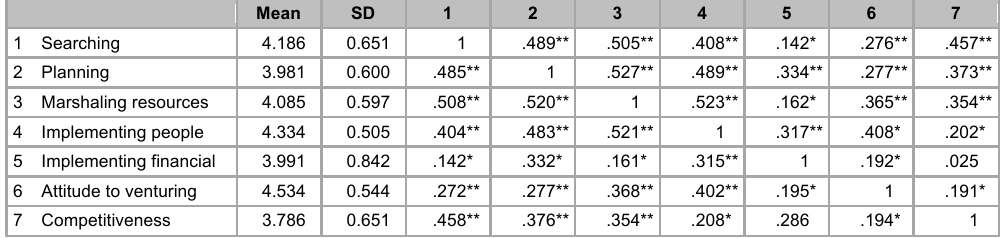
Descriptives and correlations for venture creation phases and competitiveness Mean